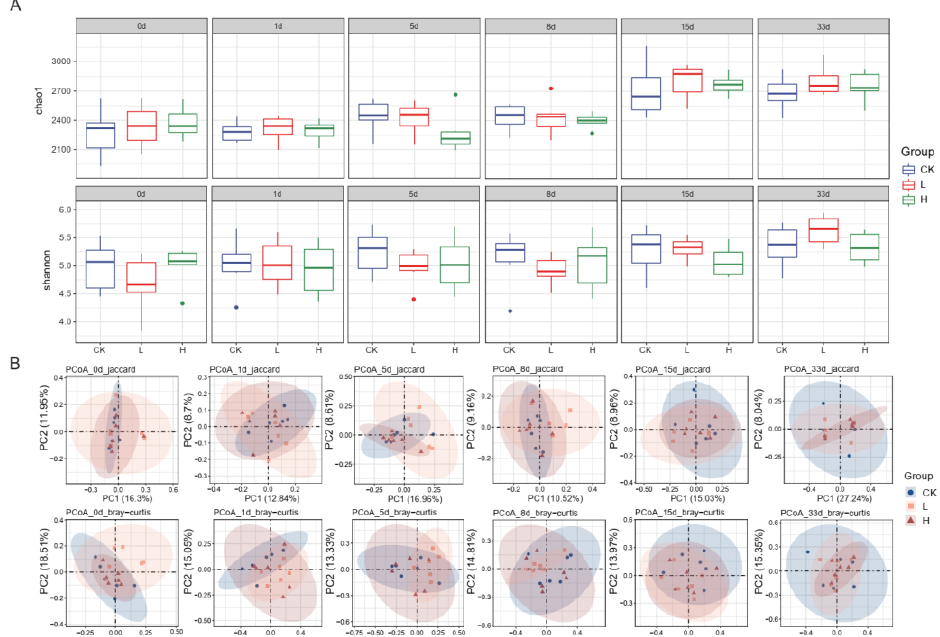
Figure 2. ( A ): The α -diversity of the bacterial community, including Shannon and Chao1 indexes in pig feces; the two indexes of each group on days 15 and 33 were significantly increased compared to on days 0, 1, 5 and 8 in each group ( p < 0.05). ( B ): The β -diversity of the bacterial community in pig feces by PCoA based on binary Jaccard distance and Bray–Curtis distance; the confidence ellipse was set at the 95% level based on the β -diversity of samples on the same day.